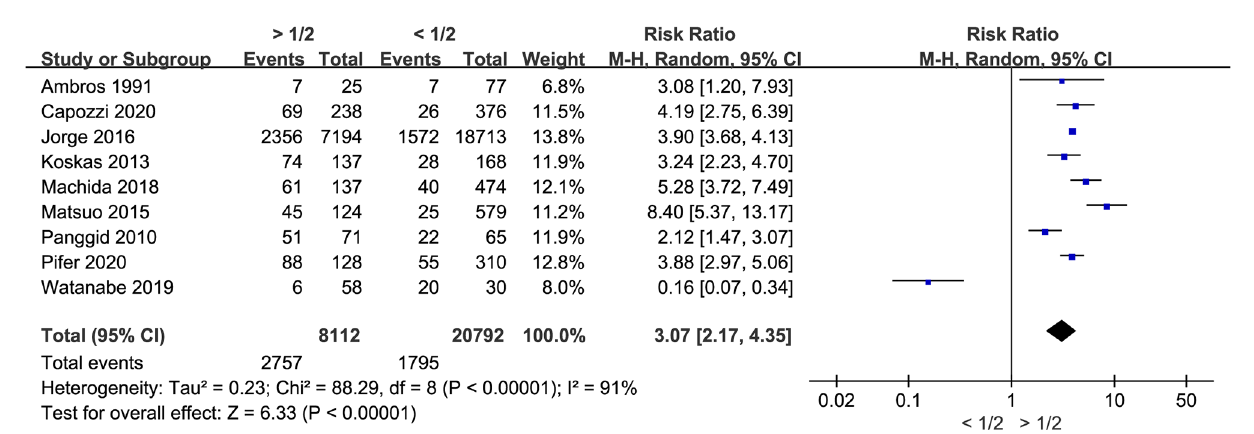
FIGURE 1 | Meta-analysis of the association between myometrial invasion and LVSI in endometrial